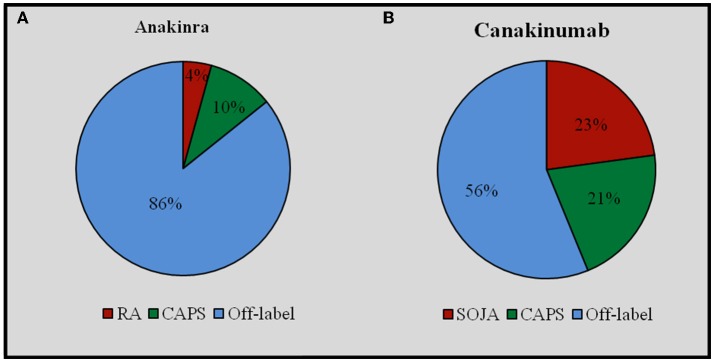
On-label and off-label use of Anakinra (A) and Canakinumab (B). CAPS, Cryopyrin-Associated Periodic Syndrome; RA, rheumatoid arthritis; SOJA, Systemic Onset Juvenile Idiopathic Arthritis.